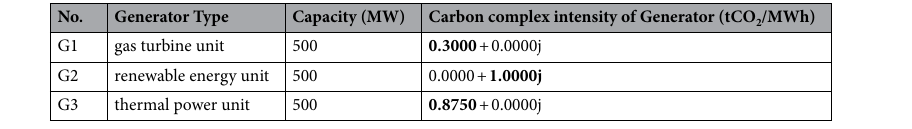
Table 1. Parameters of the generator of the 6-bus test system. Significance values are in bold.